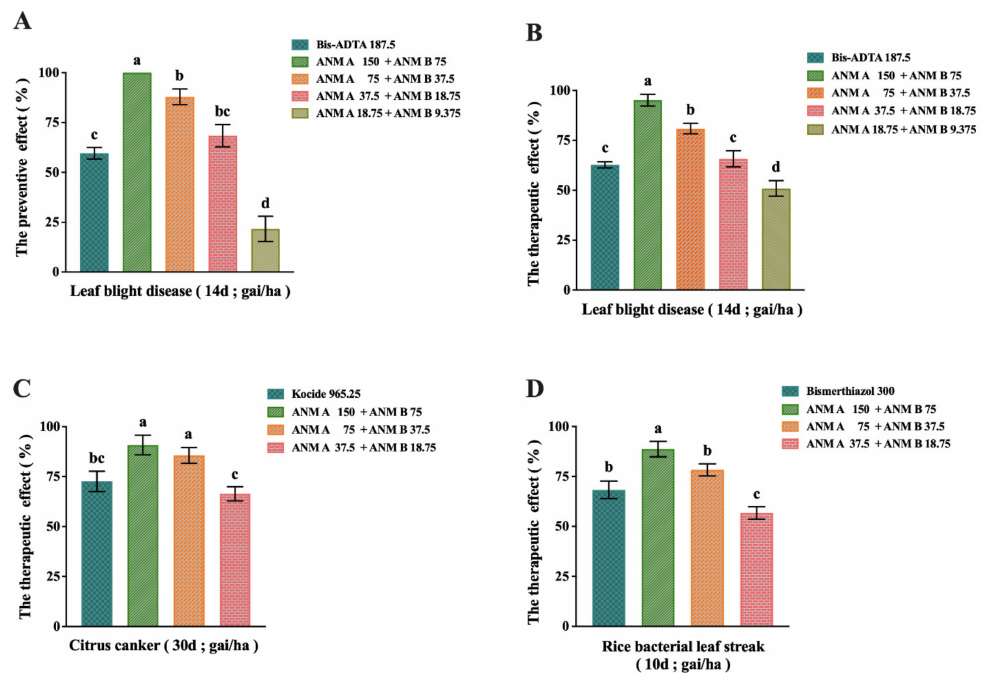
Figure 5. Evaluation of in vivo antibacterial activity of ANM A. ( A ) Preventive effect of ANM (A + B) on rice bacterial leaf blight caused by X. oryzae pv. oryzae ; ( B ) therapeutic effect of ANM (A + B) on rice bacterial leaf blight caused by X. oryzae pv. oryzae ; ( C ) therapeutic effect of ANM (A + B) on citrus canker caused by X. citri ; ( D ) therapeutic effect of ANM (A + B) on rice bacterial leaf streak caused by X. oryzae pv. oryzicola. The data are shown as means ± SD of three independent experiments. Lowercase letters indicate significant differences ( p < 0.05) between any two